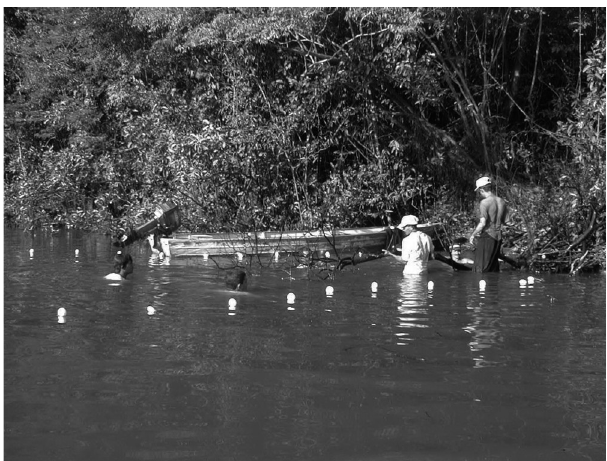
Fig. 3. Sampling of a small submerged tree crown or ‘galhada’ in the Uxi bay of lago Amanã, using a 50 x 8 m seine net and team of fishermen.